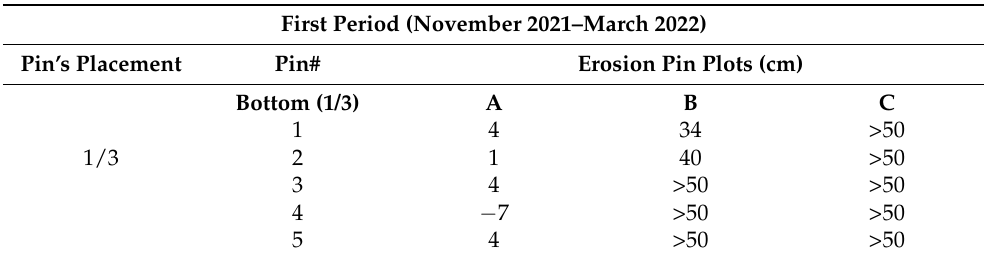
Figure 2. The eight cross-sections (red lines) and three erosion pins plots (blue dots) as located on studied reach of Kallifitos torrent, Drama, Greece. Between cross-sections 4 and 5 is an Irish bridge. The light color area indicates the area that was captured by the drone during the six flights. The erosion pin method (Figure 3) was selected due to its practicability for short time- scale investigations and its results have high accuracy (up to 5 mm) [65]. The length of the pins was 80 cm, because erosion rates of up to 50 cm per erosion event were witnessed in similar-sized streams [66]. A pin diameter of 1 cm was selected because it was small enough to cause minimum disturbance to the banks but large enough to not bend under most high-discharge events [67]. A total of three erosion pins was installed. One of the plots was within the area captured by the drone flights while the others were upstream. Each erosion pin plot included two horizontal rows of five pins each (Figure 4) in- stalled on bare banks. Pins within these rows were placed 1 m apart for a total length of 4 m. To consistently place the pins in similar bank positions among the streambanks, the horizontal rows were placed at 1/3 and 2/3 of the height of the bank. The Kallifitos torrent has three erosion pin plots, specifically A: X:514557,150 Y:4554900,600, B: X:515011,382 Y: 4555136,200 and C: X:514334.900 Y:4554791.400 (see Table 1) in three different locations of the torrent (Figure 2). The specific reach (captured by the drone) includes only one pin, plot C. The measurement period is during the last winter (specifically the pins were in- stalled in November 2021 and measured in March 2022 and June 2022). Figure 3. Erosion pins installed and measurements after erosion ( left ) and deposition ( right ) events. Table 1. The results of the erosion pin methodology measured at 2 different periods.